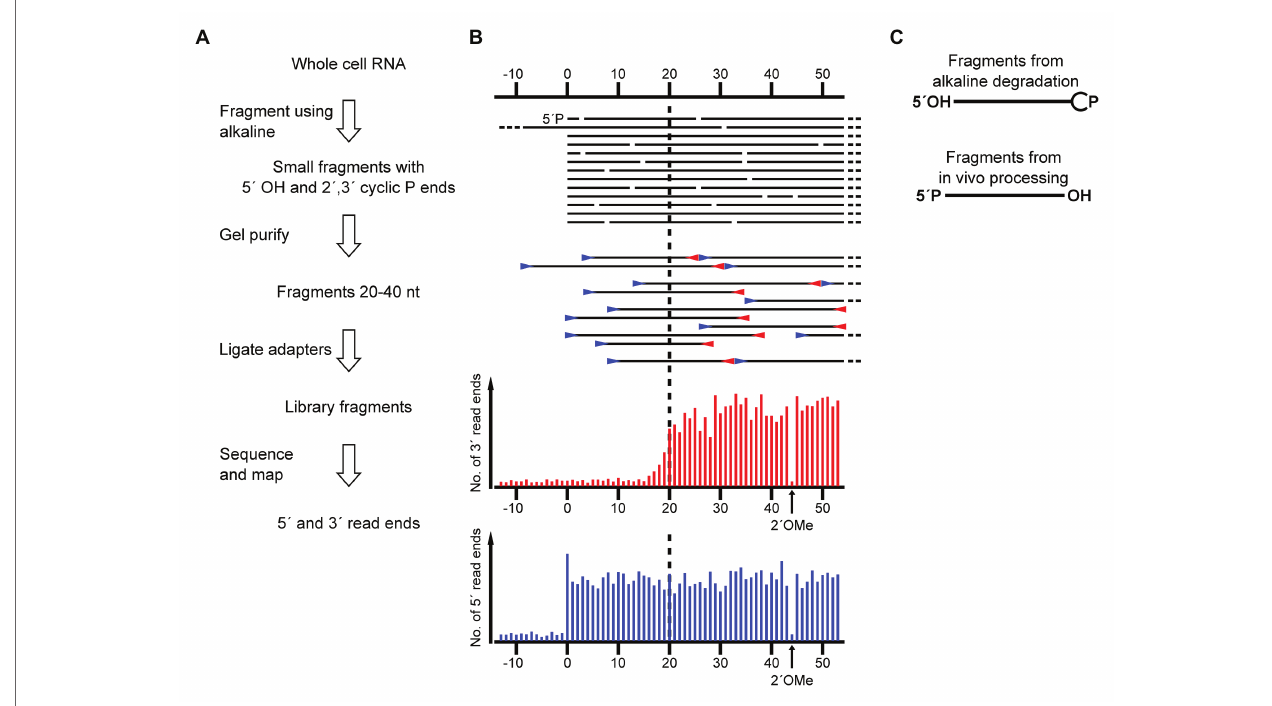
FIGURE 1 | Schematic showing the application of RiboMeth-seq for analysis of native RNA ends. (A) Flow diagram of the steps in RiboMeth-seq. (B) Drawing of the fragments generated during the RiboMeth-seq protocol and the resulting read end coverage obtained at a native end. Note that the high number of read ends at the position corresponding to the native end as well as the depletion of 3 ´ read ends corresponding to the first 20 nt of the fragment carrying the native 5 ´ end. The depletion is caused by the loss of fragments <20 nt in length in the gel purification step. The signature resulting from a single 2 ´ OMe in the RNA is indicated in the read end diagram. (C) Drawing highlights the end groups of internal fragments from alkaline degradation contrasted with RNA processing fragments from hydrolytic cleavages.